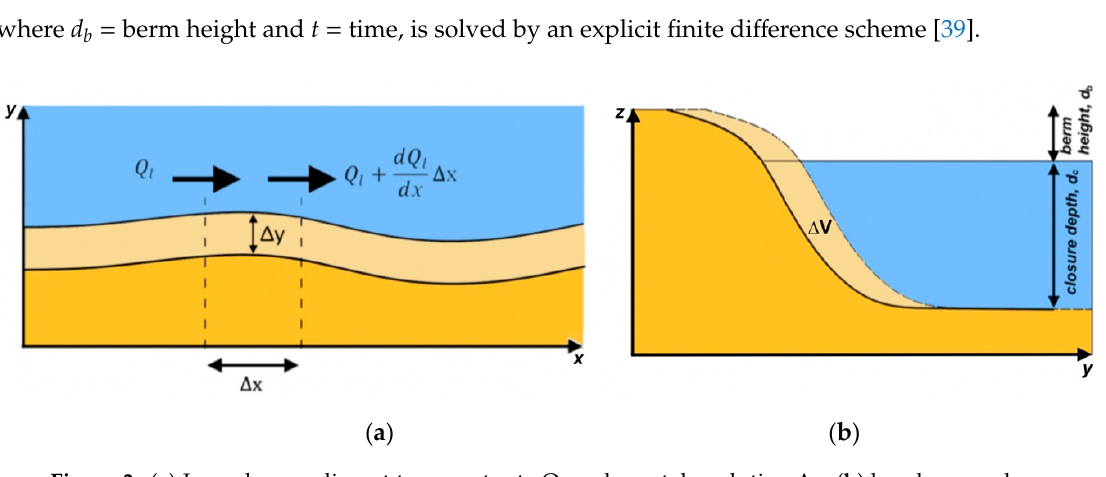
Figure 3. ( a ) Longshore sediment transport rate Q l and coastal evolution ∆ y; ( b ) beach cross-shore profile